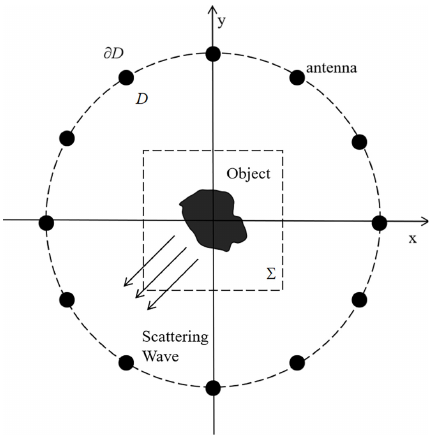
Figure 1. Electromagnetic inverse scattering measurement